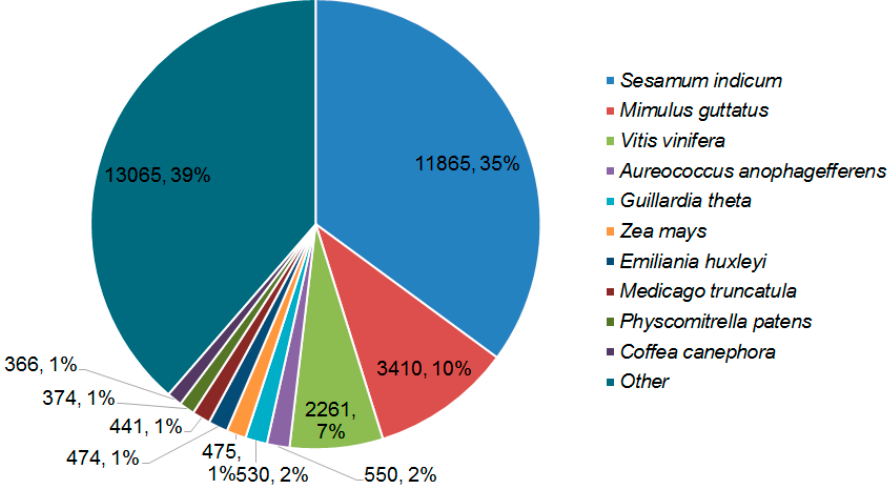
Figure 2. Hit species distribution of BLASTX matches of P. aegyptiaca transcriptome. Number and proportion of P. aegyptiaca transcripts with similarity to sequences from the NR database.